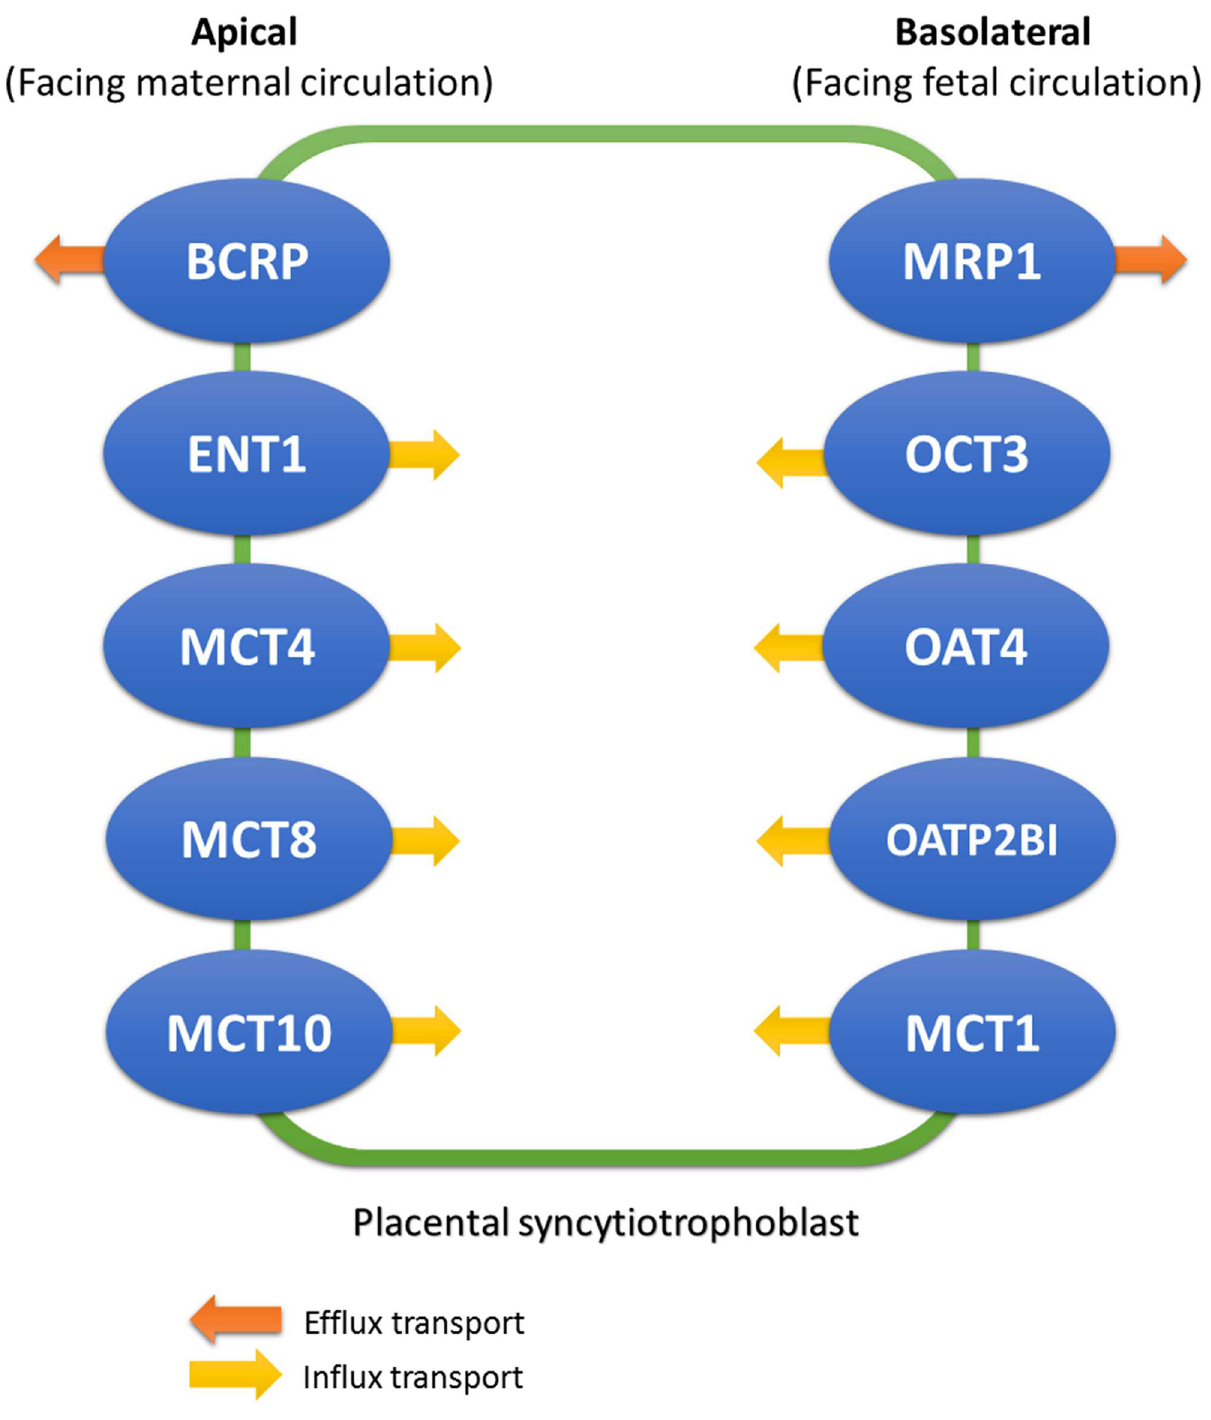
Fig 1. Placental transporterproteins are expressedon either side of the placenta. Five transporter proteins are expressedin the apical (maternal-facing)layer of placentalcells, which includebreast cancer resistanceprotein (BCRP), equilibrativenucleoside transporter (ENT), monocarboxylate transporter 4, 8, 10 (MCT4, MCT8, MCT10). Another five are expressedin the basolateral(fetal-facing) layer of placental cells, includingmultidrug resistance-associatedprotein (MRP), organic cation transporter 3 (OCT3), organic anion transporter 4 (OAT4), organicanion transportingpolypeptide 2B1 (OATP2B1) and monocarboxylate transporter 1 (MCT1). The arrows show the directionof substrate transport through the cells.